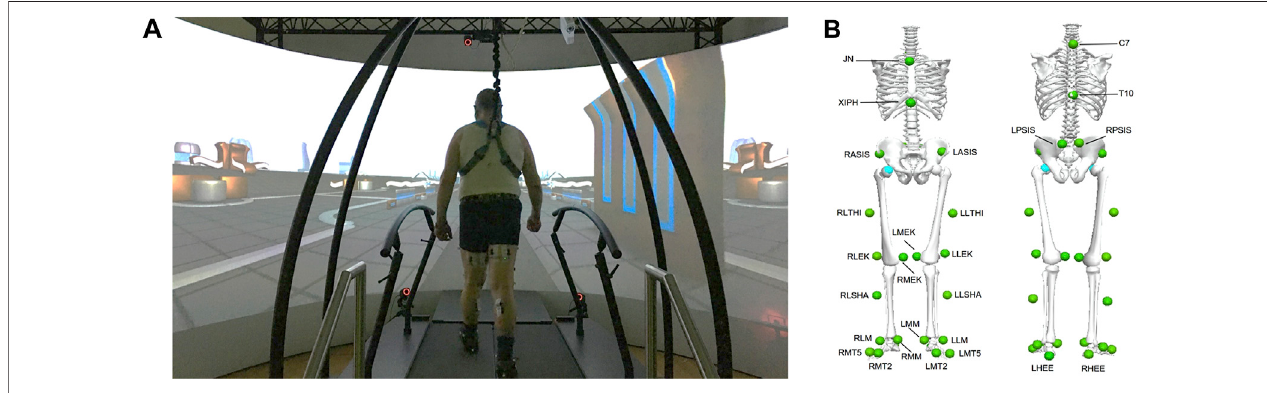
FIGURE1| TheGaitReal-TimeAnalysisInteractiveLab(GRAIL)andtheindustrial-stylevirtualrealityscenarioinvolvedinthisstudy (A) ;frontandrearviewofmarker set used in Human Body Model (v2) with its speci fi c 26 markers (green), which involves the anatomical positions of the lower extremities and trunk (B) .